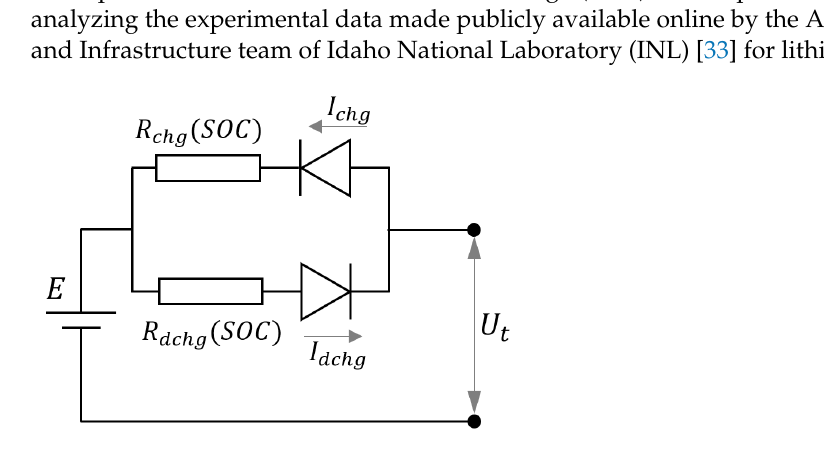
Figure 3. Electric battery equivalent circuit